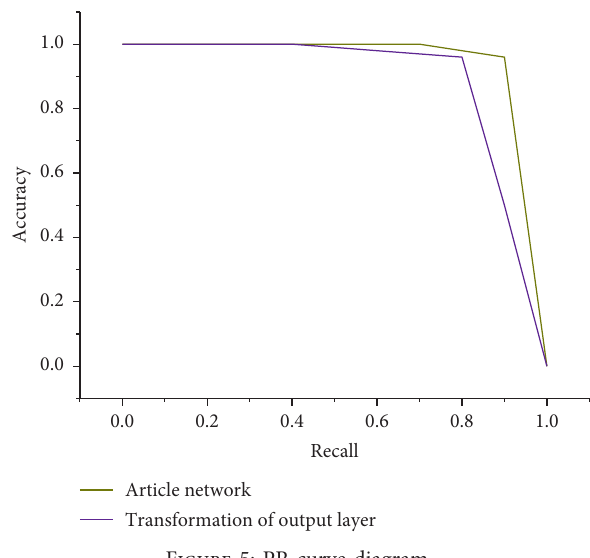
Figure 5: PR curve